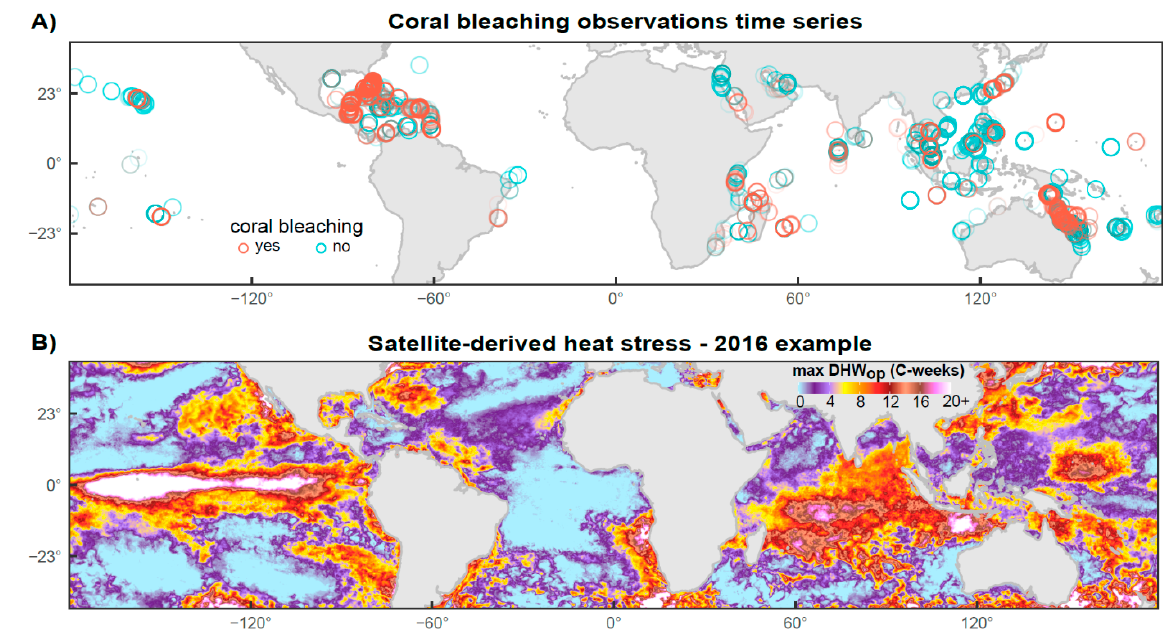
Figure 1. ( A ) Distribution of coral bleaching survey records based on estimates of percentage coral bleaching (<10% = no, >20% = yes), measured at 5724 sites from 84 countries between 2003 and 2017 (N = 10,380) after four layers of a priori filtering (i.e., removal of errors, matching surveys with the period of peak thermal exposure in the year, accounting for inconsistent sampling protocols and accounting for spatiotemporal patchiness). ( B ) World map of maximum levels of heat stress reached in 2016 as shown by the maximum operational Degree Heating Week (DHW op ) metric derived from 5 km resolution satellite-based sea surface temperature data. Marine heatwaves in 2016 caused widespread mass coral bleaching globally. Coral bleaching observations from specific locations and years ( A ) were matched with maximum DHW values from the 5 km grid cell surrounding the observation coordinates (e.g., B ).